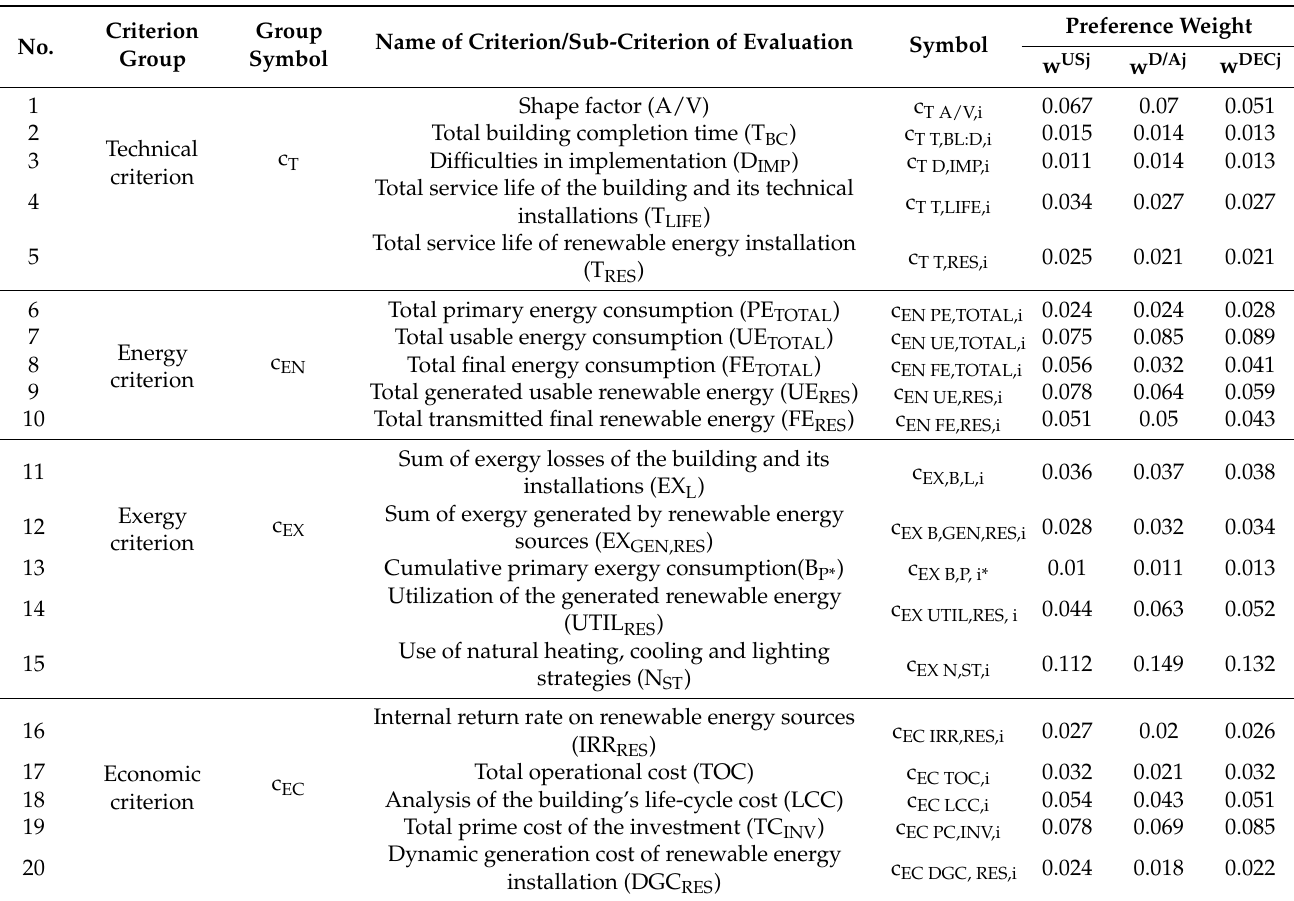
Table 6. Target weights for all evaluation sub-criteria—“Current/Future user”, “Designer/Architect” and “All decision